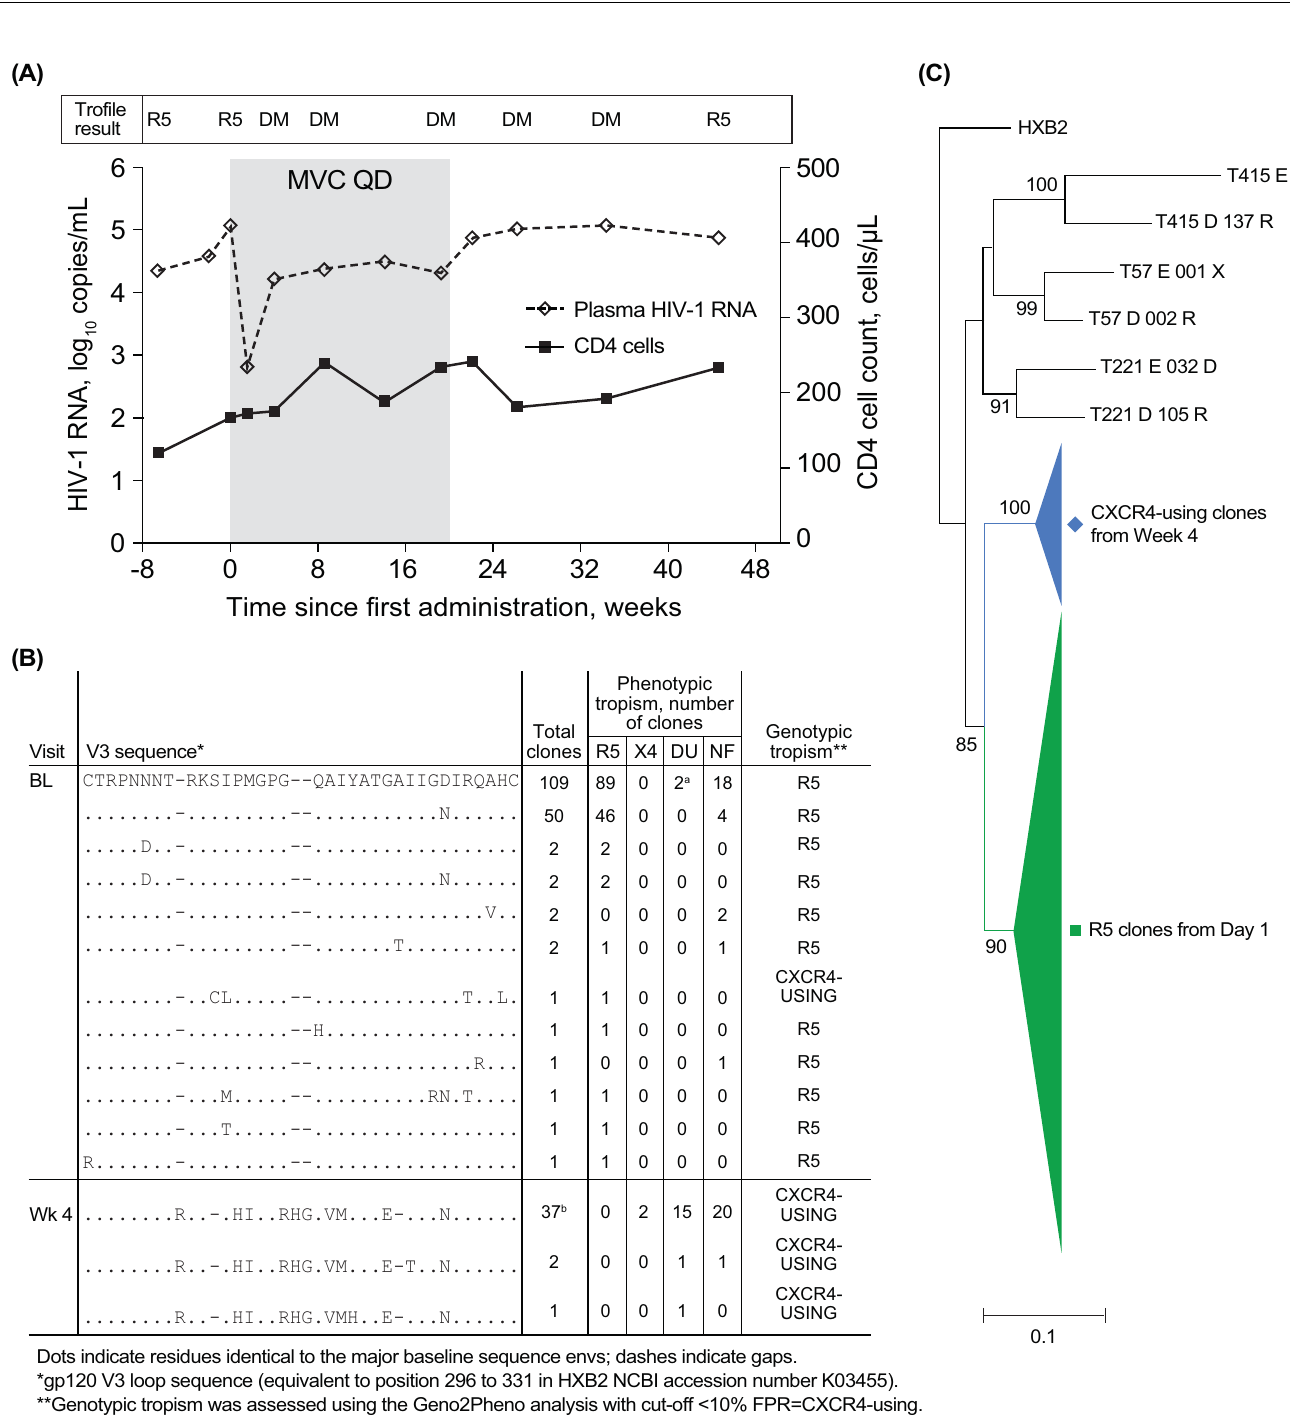
PLOS ONE | https://doi.org/10.1371/journal.pone.0204099 December26,